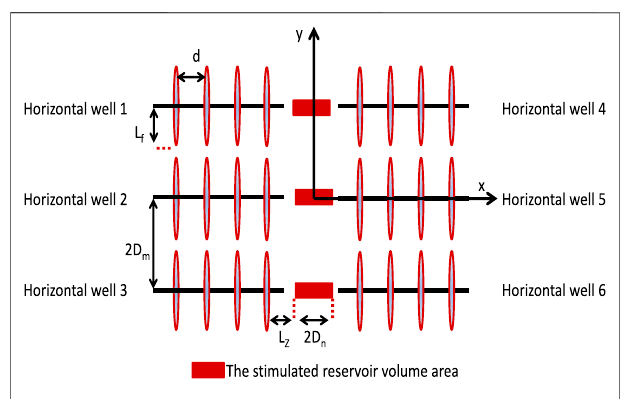
FIGURE 7 | Schematic diagram of interference effect at fracture